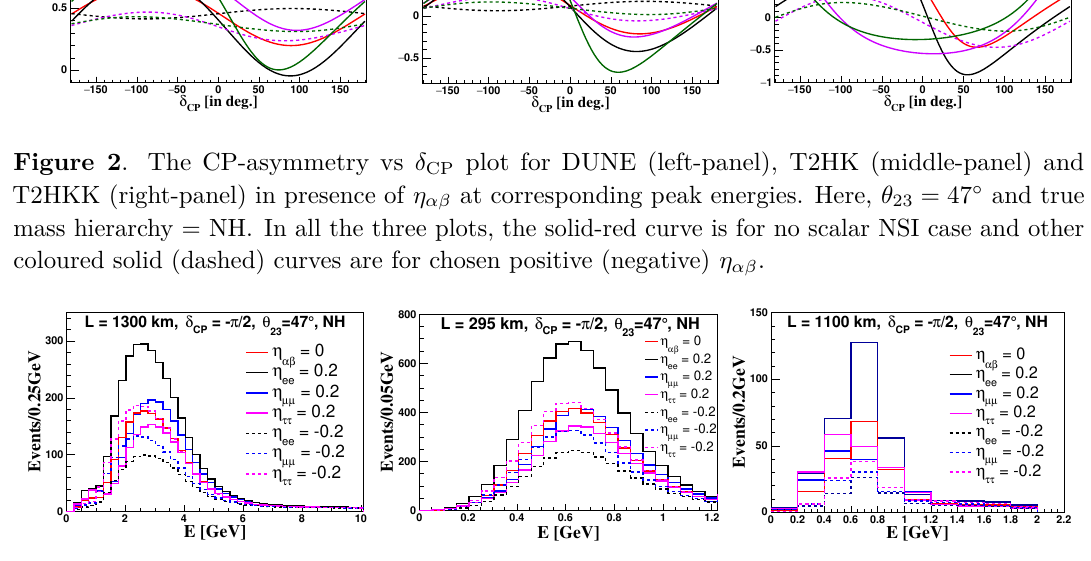
Figure 3 . The binned event rates of DUNE (left), T2HK (middle) and T2HKK (right) as a function of neutrino energy at δ = − π /2, θ = 47 ◦ and NH for different choices of η CP 23